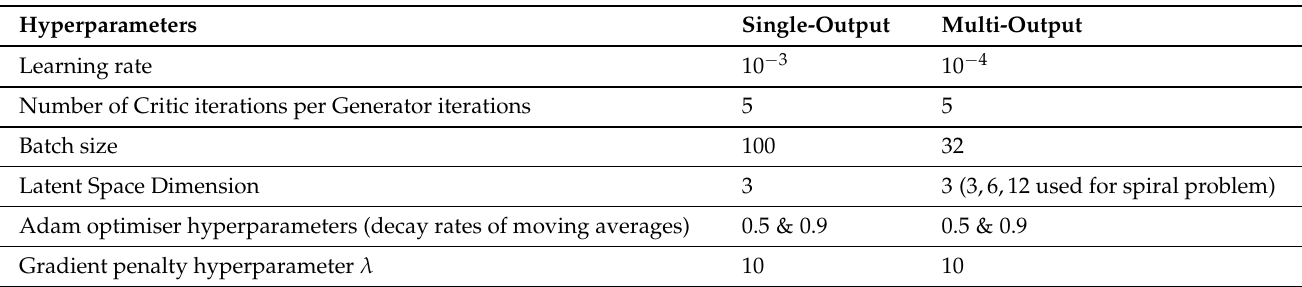
Table 2. Hyperparameters used in the construction and training of our WGANs for both the single- output and multi-output